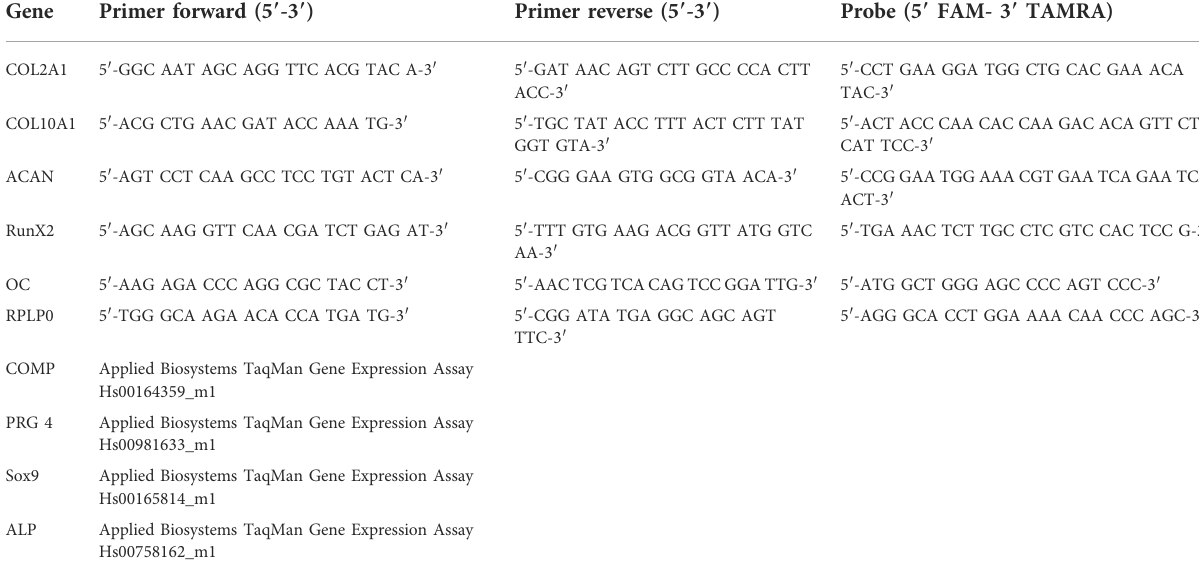
TABLE 2 Details of source material from each donor